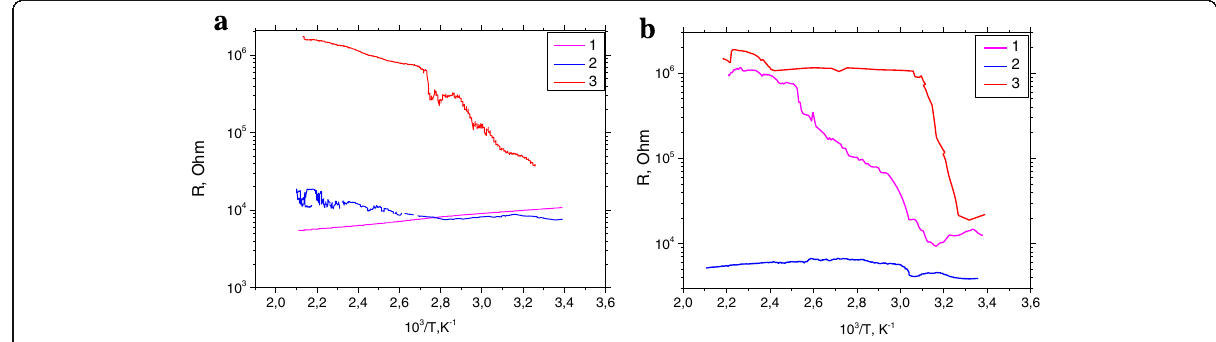
Fig. 3 Change in resistance of the samples ( 1 PLD, 2 PLD-200A, and 3 PLD-300) heating for as-growth thin films ( a ) and annealed ( b